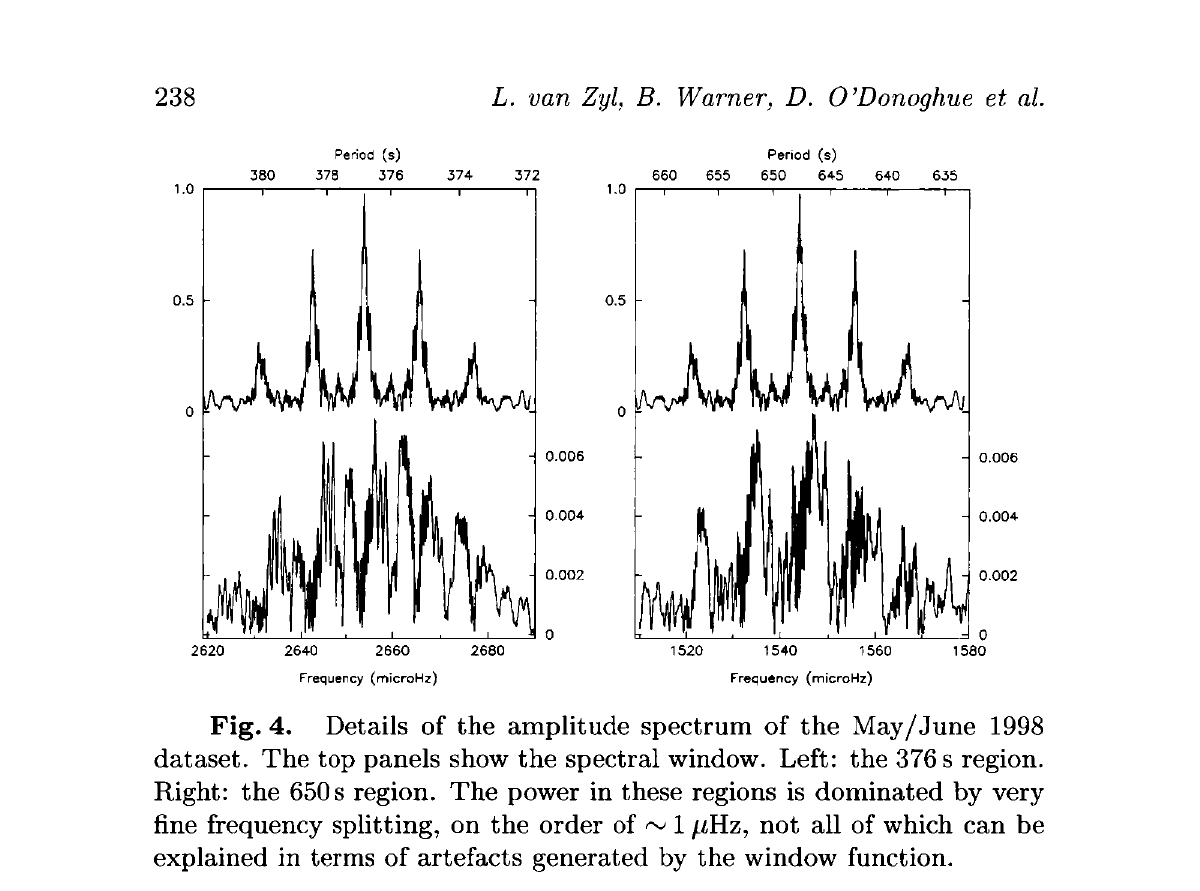
Fig. 4. Details of the amplitude spectrum of the May/June 1998 dataset. The top panels show the spectral window. Left: the 376 s region. Right: the 650 s region. The power in these regions is dominated by very fine frequency splitting, on the order of ~ 1 /¿Hz, not all of which can be explained in terms of artefacts generated by the window